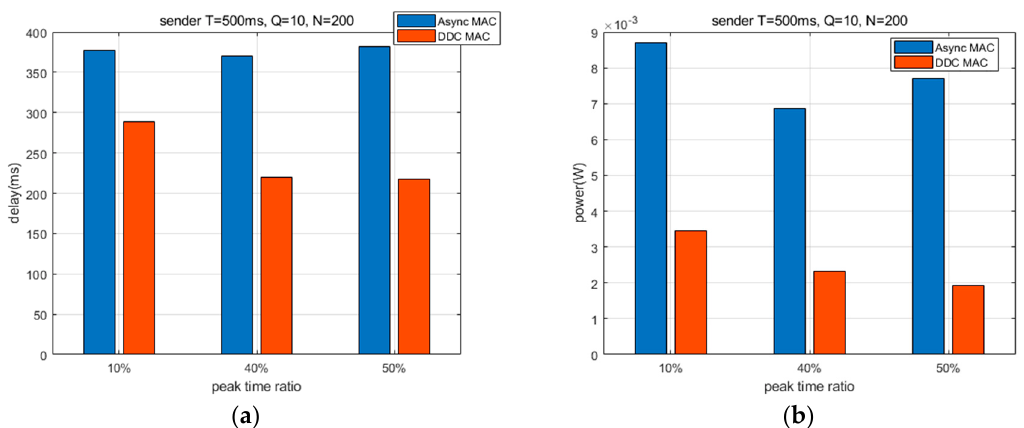
Figure 8. The comparison of latency and energy consumption of the asynchronous MAC and DDC-MAC in peak time traffic: ( a ) delay; ( b ) energy consumption/s/node.